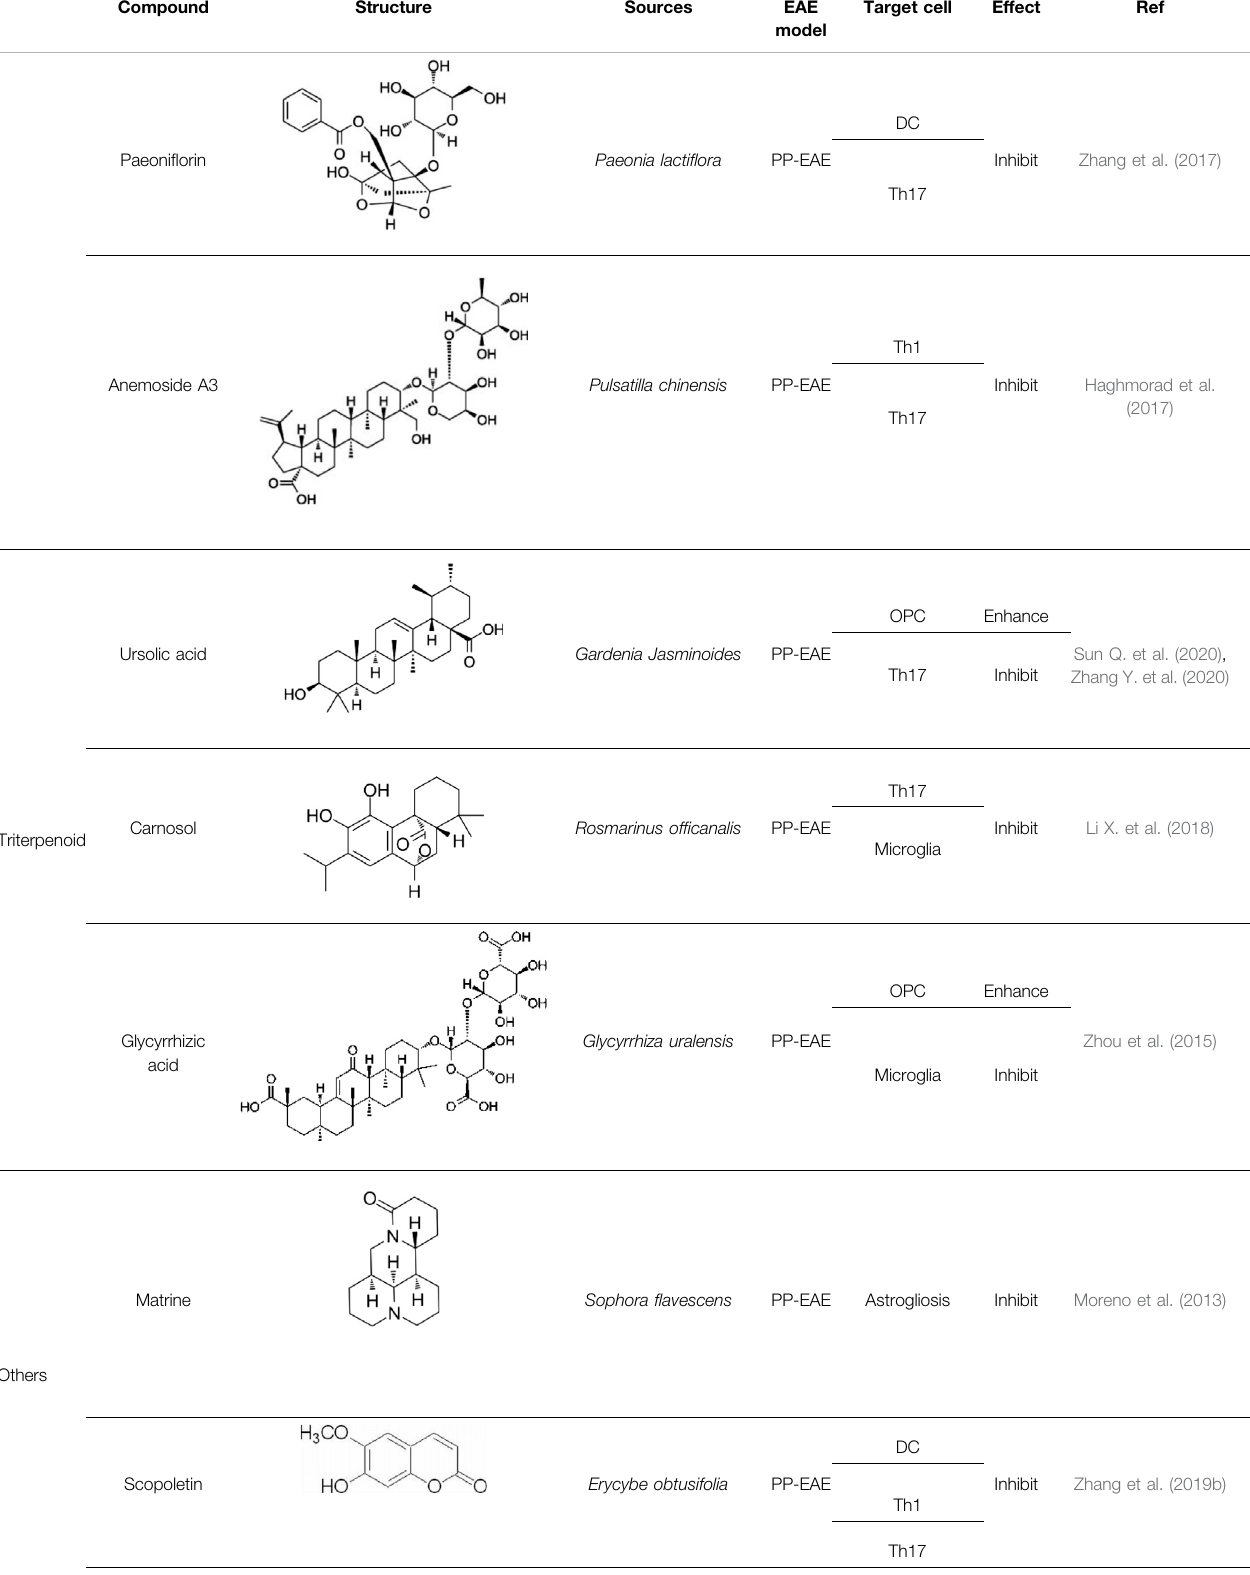
TABLE 1 | ( Continued ) Natural products act on the target cells of